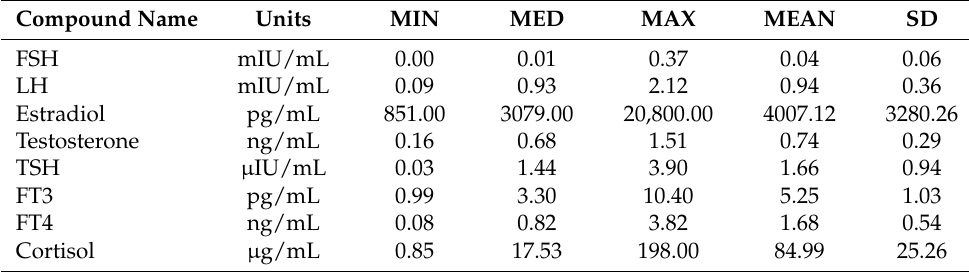
Table 3. Descriptive statistics of hormonal